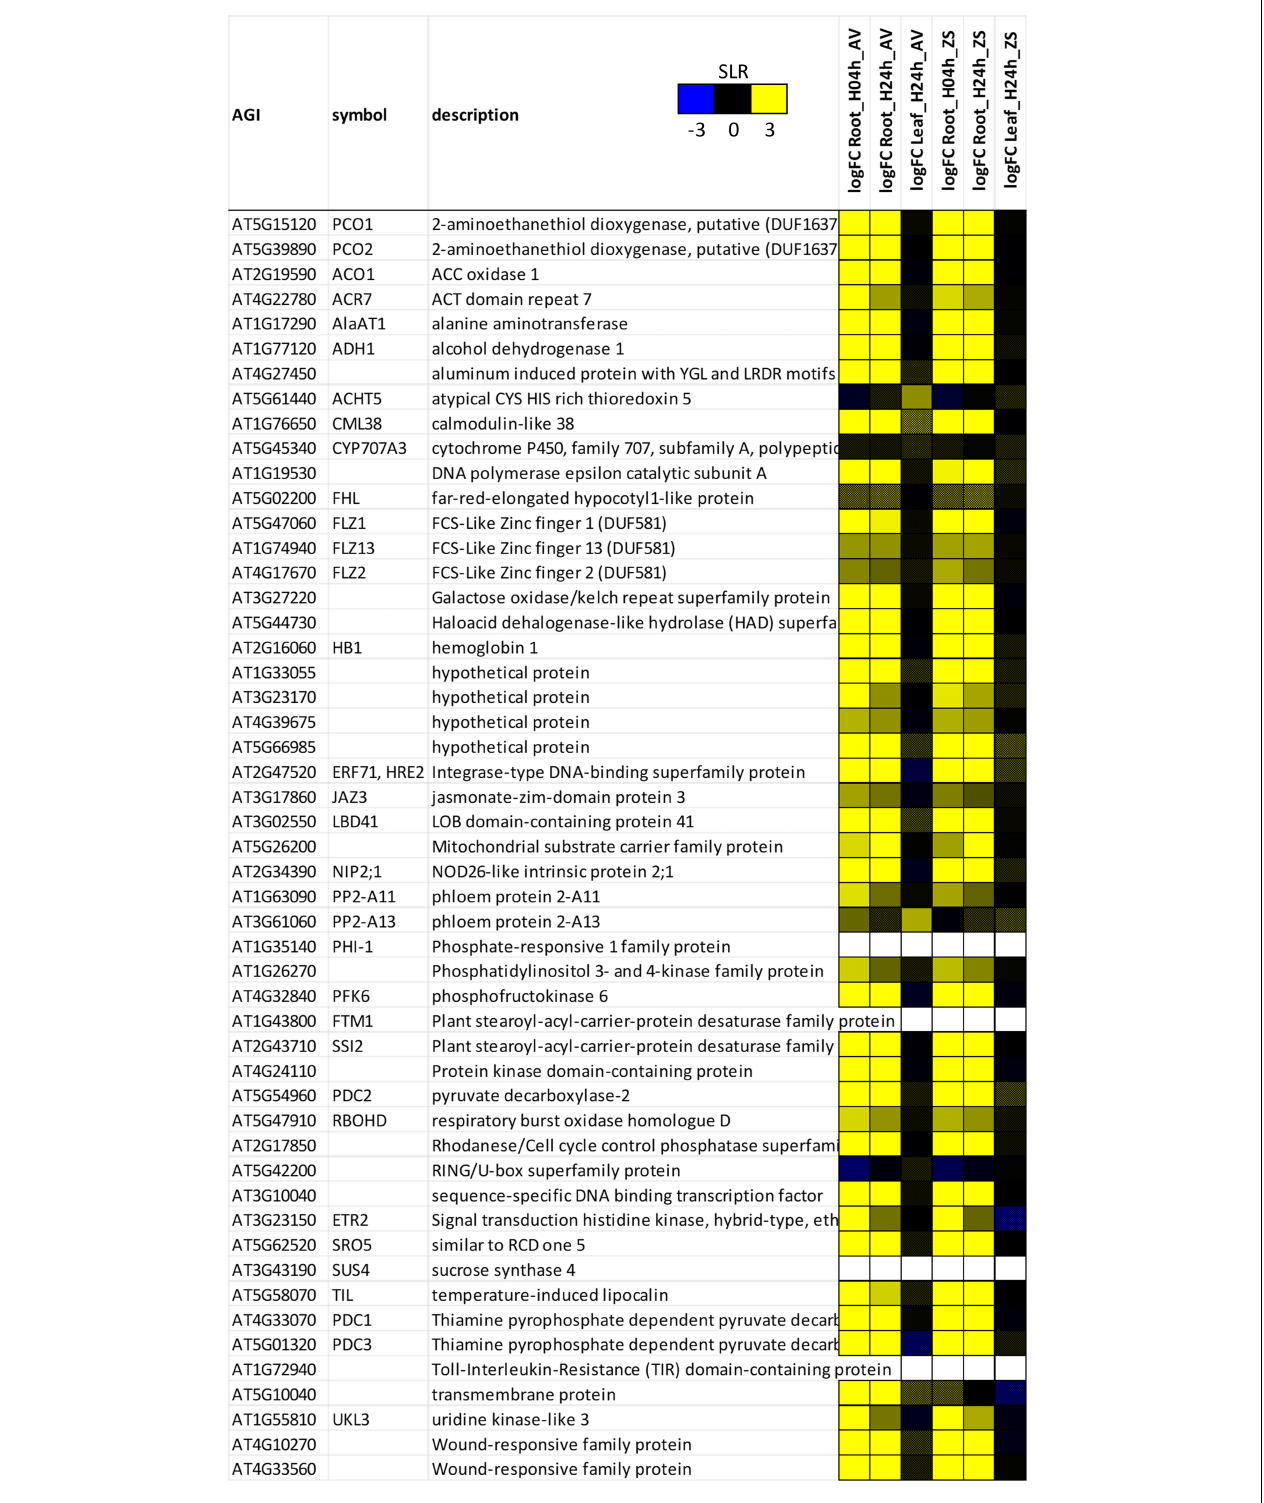
FIGURE 2 | Heatmap of hypoxia core-response genes (Mustroph et al., 2009) from the Brassica napus expression data. A summary of up to six rapeseed gene IDs for one Arabidopsis gene ID is shown. For expression of all rapeseed genes, please see Supplementary Figure 2 . Values are signal-log ratios (SLR) of summed counts of root-zone hypoxia vs. aerated control. AV, Avatar; ZS, Zhongshuang 9. The color intensity reflects the SLR values (blue, –3; yellow, + 3). Crossed cells represent values that are not significant (FDR > 0.01).